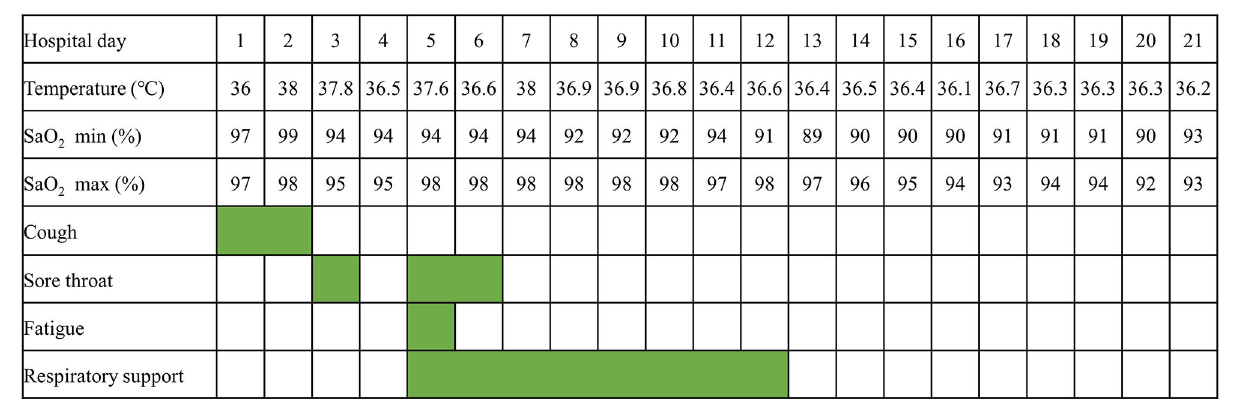
FIGURE 1 | A timeline of the symptoms and